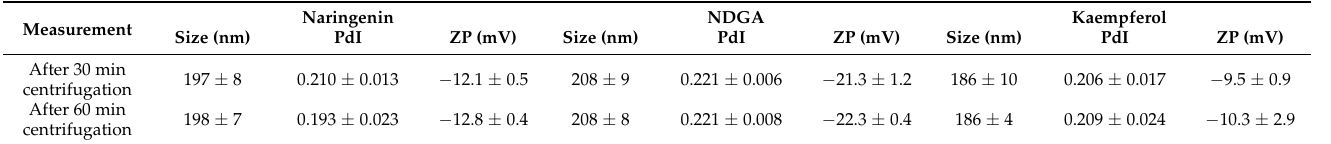
Table 5. The mean diameter (size), polydispersity index (PdI), and zeta potential (ZP) of the naringenin-, NDGA-,